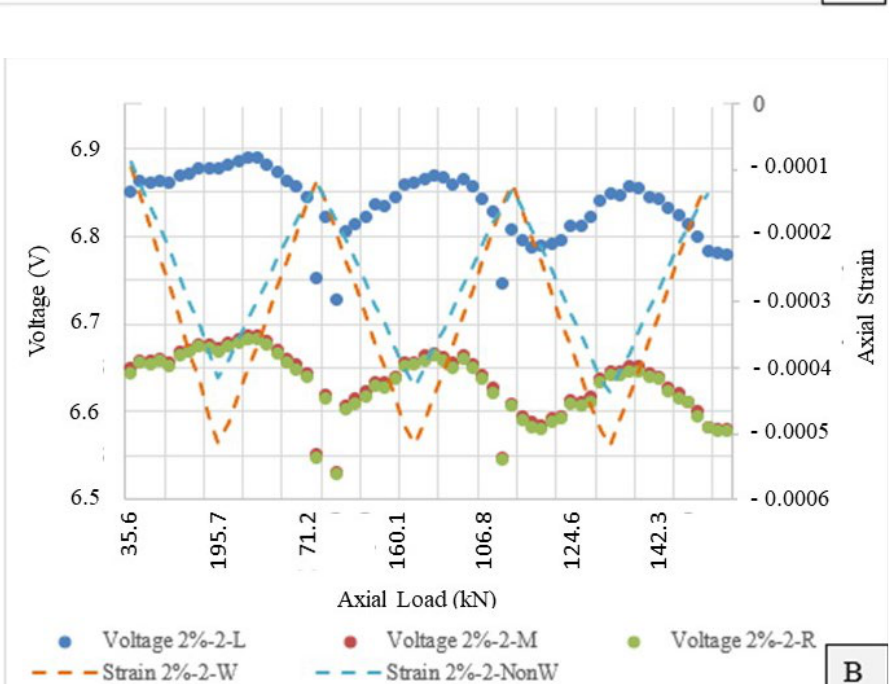
Figure 6. Strain and Voltage Measurements Time History (as a Function of Load) for 0% Specimen ( A ) and 2% Specimen First Test ( B ). ( A ) and 2% Specimen First Test ( B